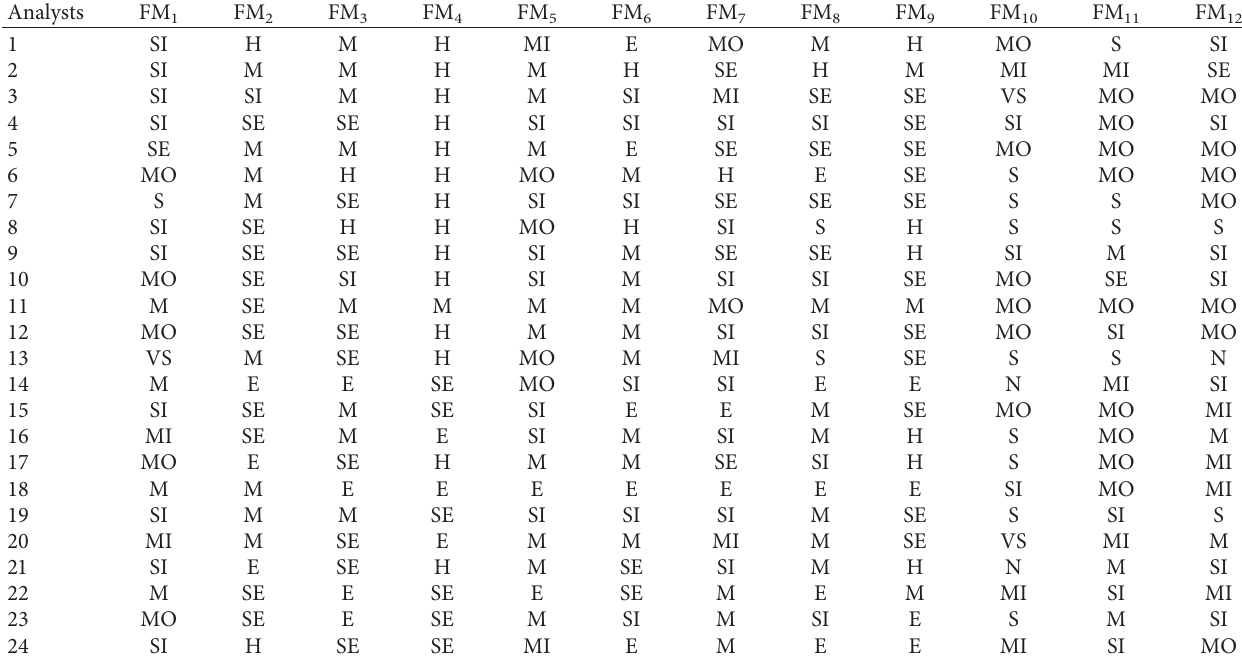
Table 2: Crisp severity ( S ) ratings from the analysts for the 12 FMs.